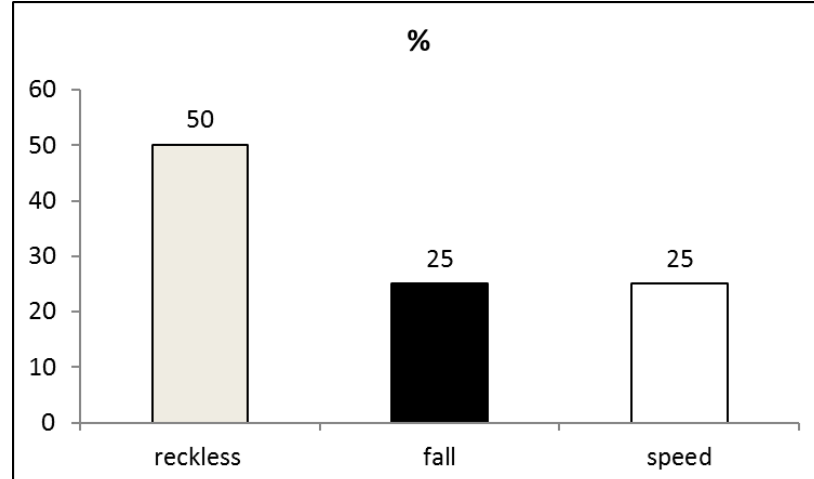
Figure 6. Causes of